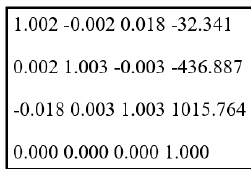
Figure 25. Computed applied transformation matrix for ICP registration method